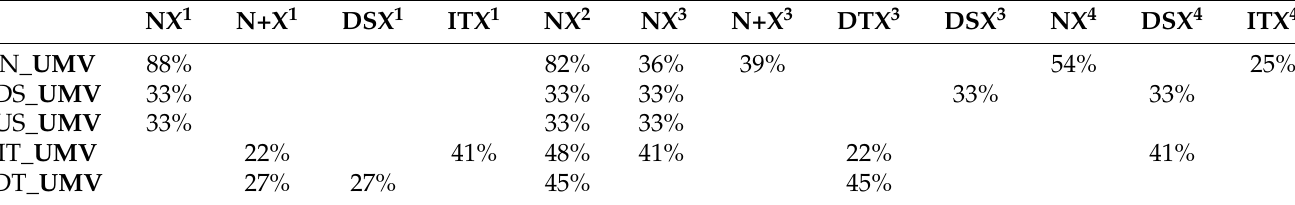
Figure 7. Pattern found in the UMV . Table 3. Conditional Probability Table related to pattern